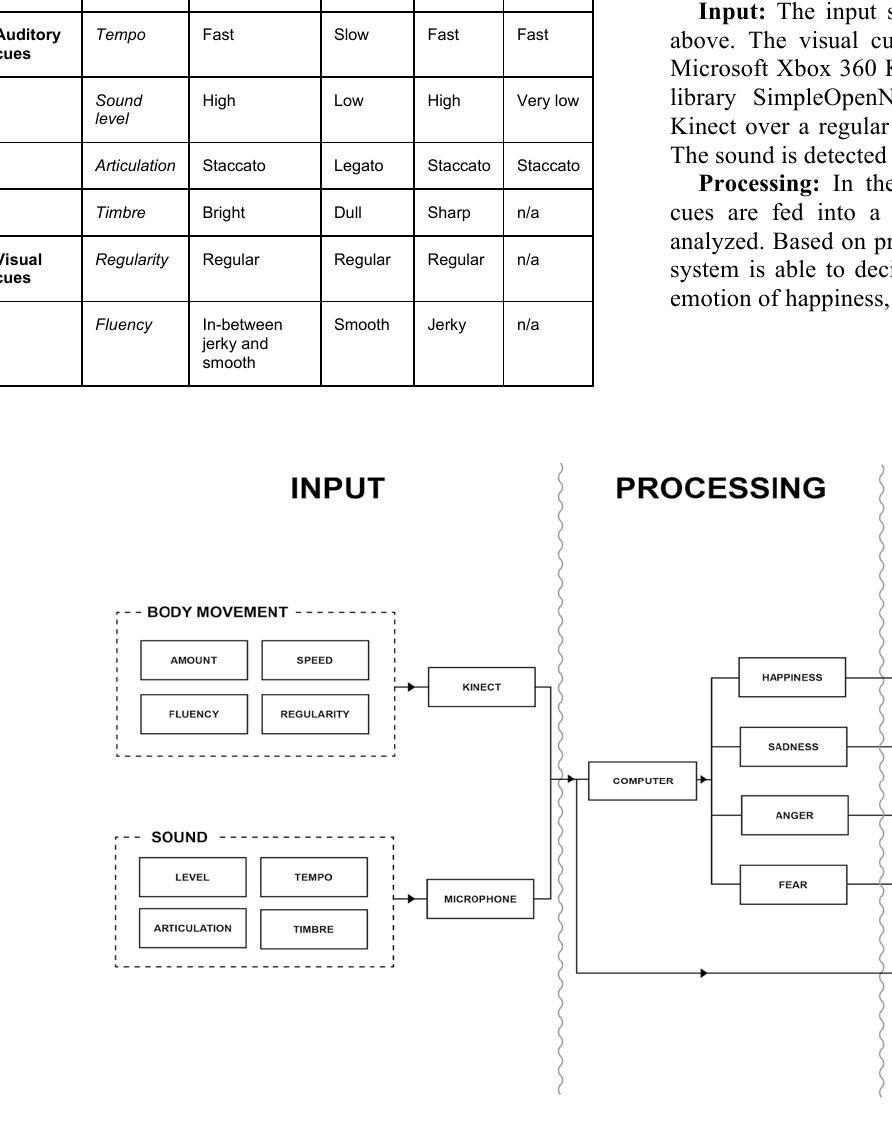
Figure 2. System